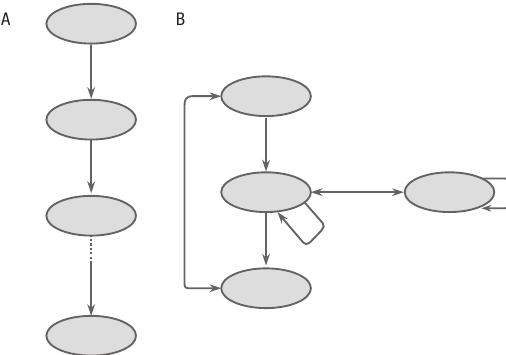
Fig. 1. Difference between a hierarchy (A) and a network (B) (Azimi et a l. 2011)